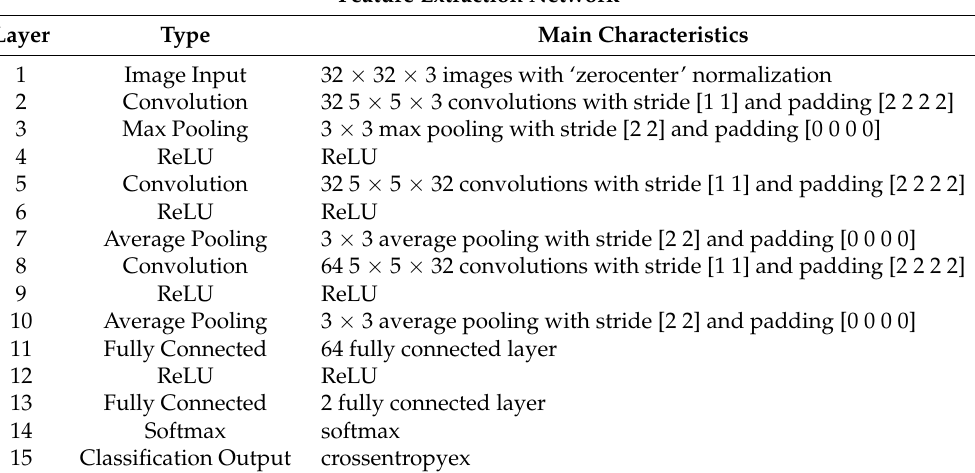
Table 4. Network layers that compose the feature extraction network. The convolution put the input images through a set of convolutional filters, each of which activates certain features from the images. The pooling layer simplifies the output by performing nonlinear downsampling, reducing the number of parameters that the network needs to learn. The rectified linear unit (ReLU) allows for faster and more effective training by mapping negative values to zero and maintaining positive values. The fully connected layer “flattens” the network’s 2D spatial features into a 1D vector that represents, and, finally, the Softmax provides probabilities for each category in the dataset image-level features for classification